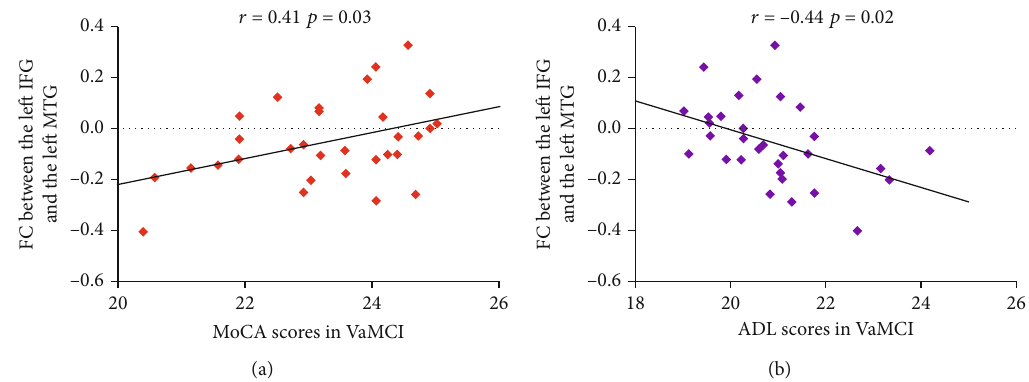
Figure 3: (a) The FC values between the left MTG and left IFG were positively correlated with the cognitive performance episodic memory measured by MoCA scores. (b) The FC values between the left MTG and left IFG were negatively correlated with ADL scores. FC: functional connectivity; MTG: middle temporal gyrus; IFG: inferior frontal gyrus; MoCA: Montreal Cognitive Assessment; ADL: activities of daily living; VaMCI: vascular mild cognitive